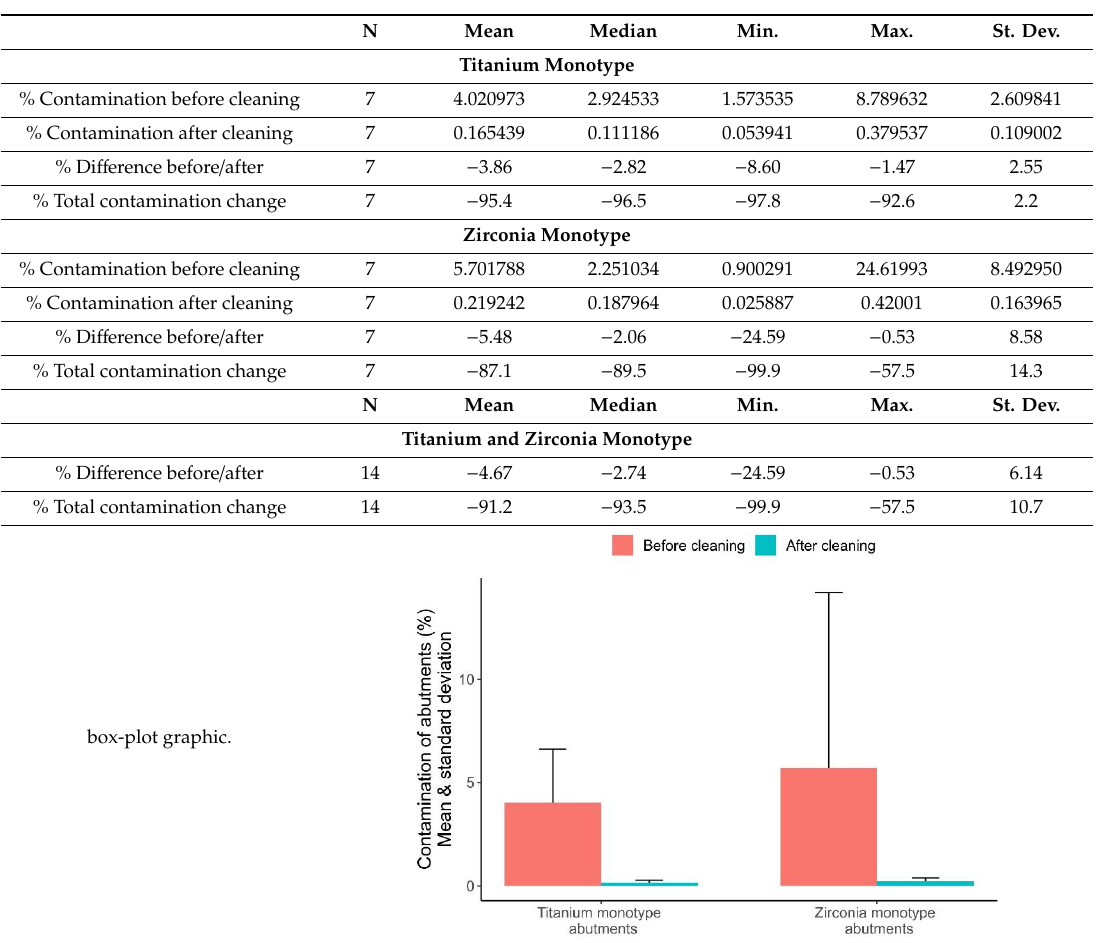
Table 8. Projected surface contamination of titanium and zirconia monotype abutment samples before and after cleaning in percent; mean, median, min., and max. Total contamination change in percent; box-plot graphic. N Mean Median Min. Max. St. Dev. Titanium